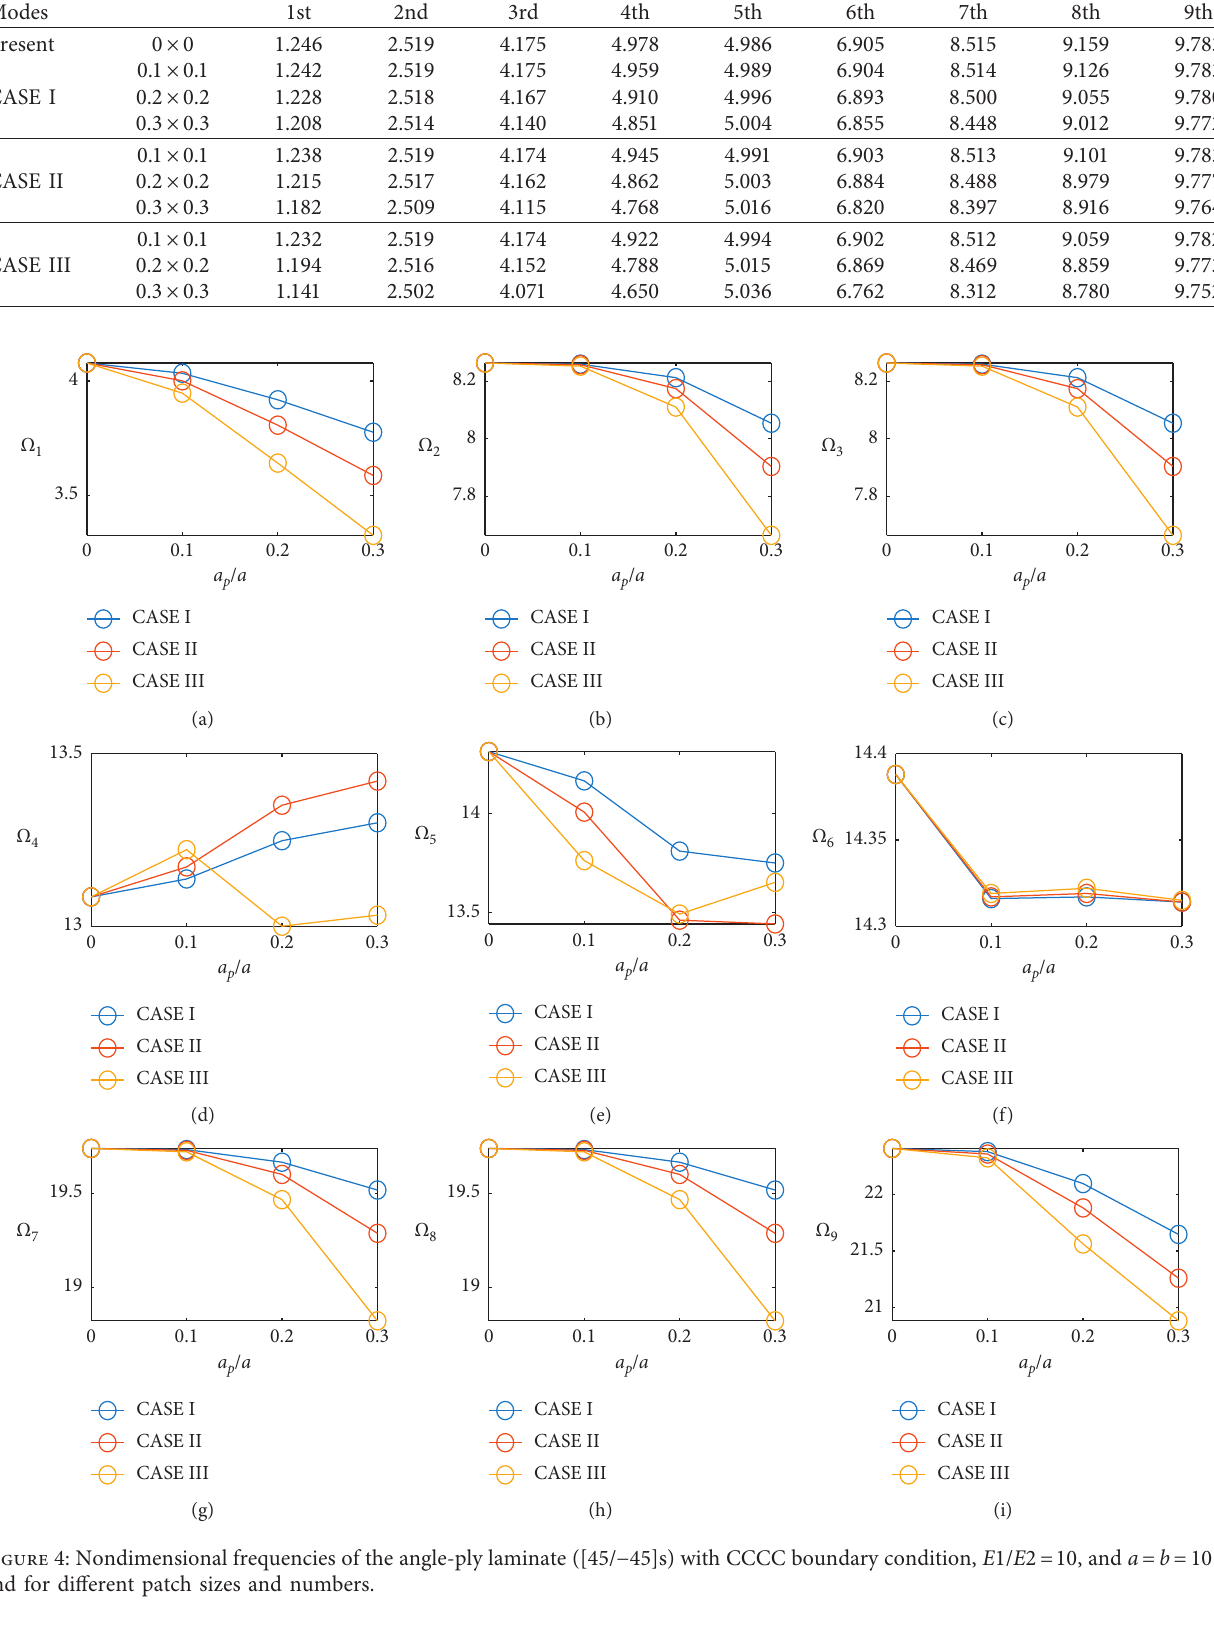
Table 6: Nondimensional frequencies of the cross-ply laminate ([0/90]s) with SSSS boundary condition, E 1/ E 2 � 10, a � 2b, and b � 10h and for different patch sizes and numbers.